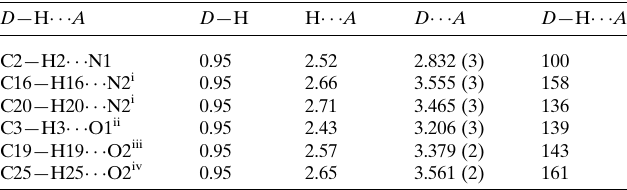
Table 3 Hydrogen-bond geometry (A˚ , (cid:3) ) for